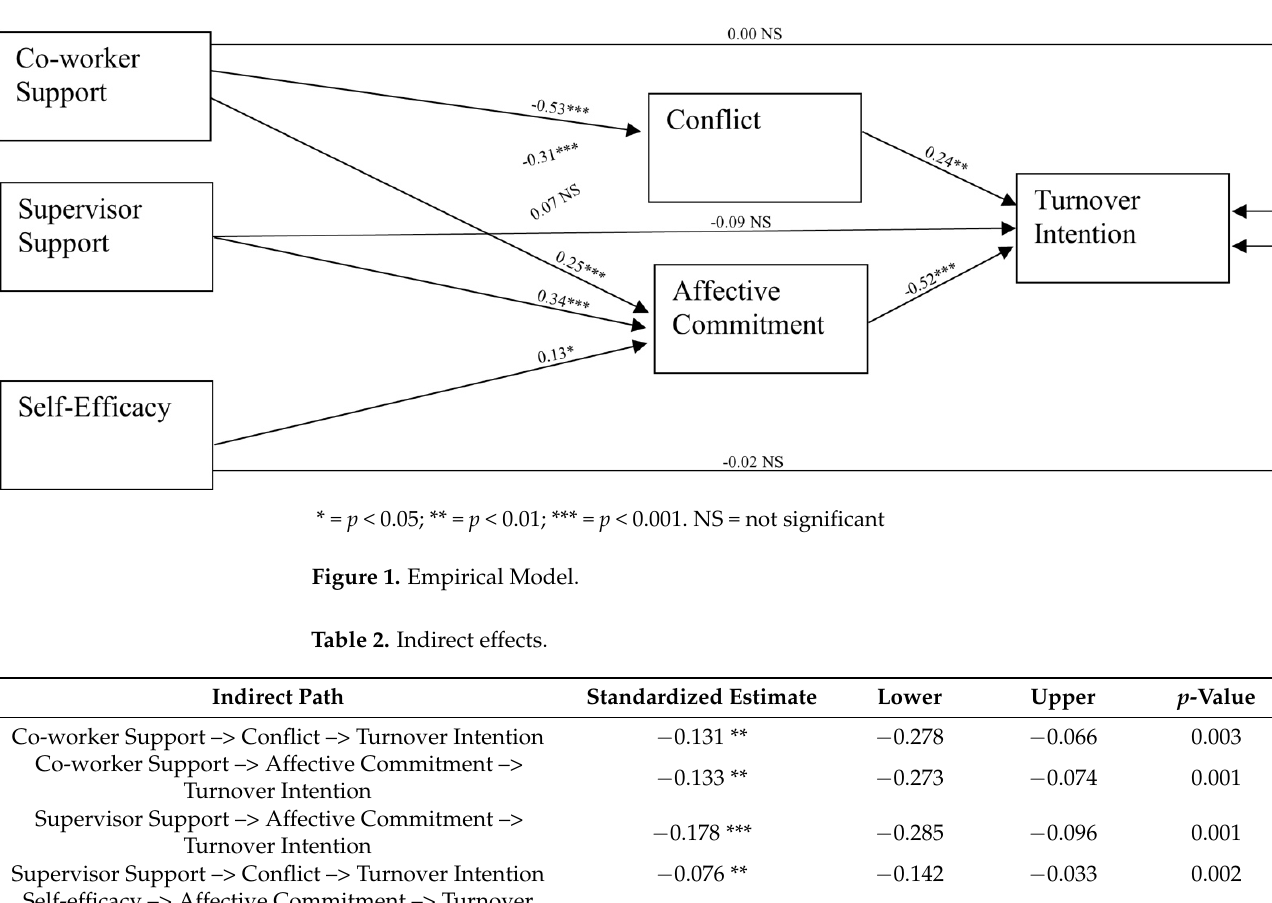
Table 2. Indirect effects.